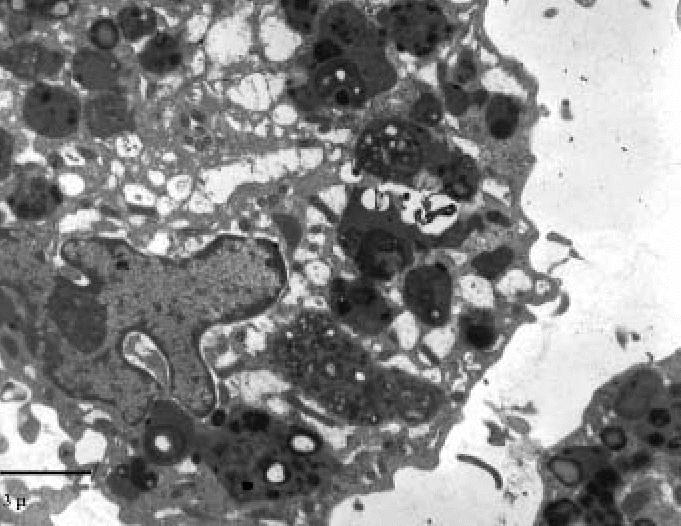
Transmission electron micrograph showing large macrophages containing prevalently complex inclusions with very dense granular deposits consistent with iron particles (exposed subject). Bar = 3 μm.